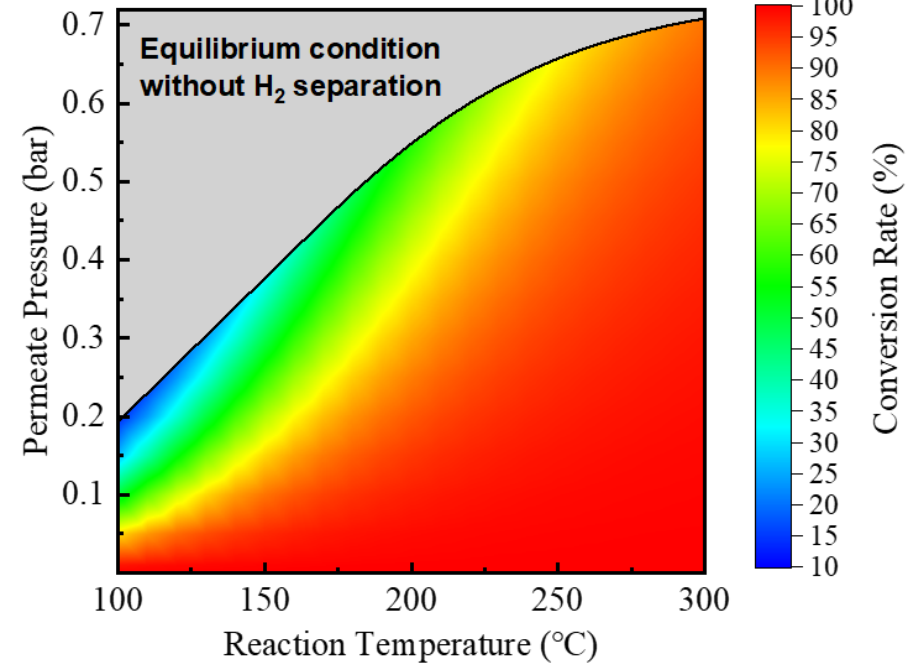
Figure 3. ESR conversion rate at different reaction temperatures and permeate pressures.